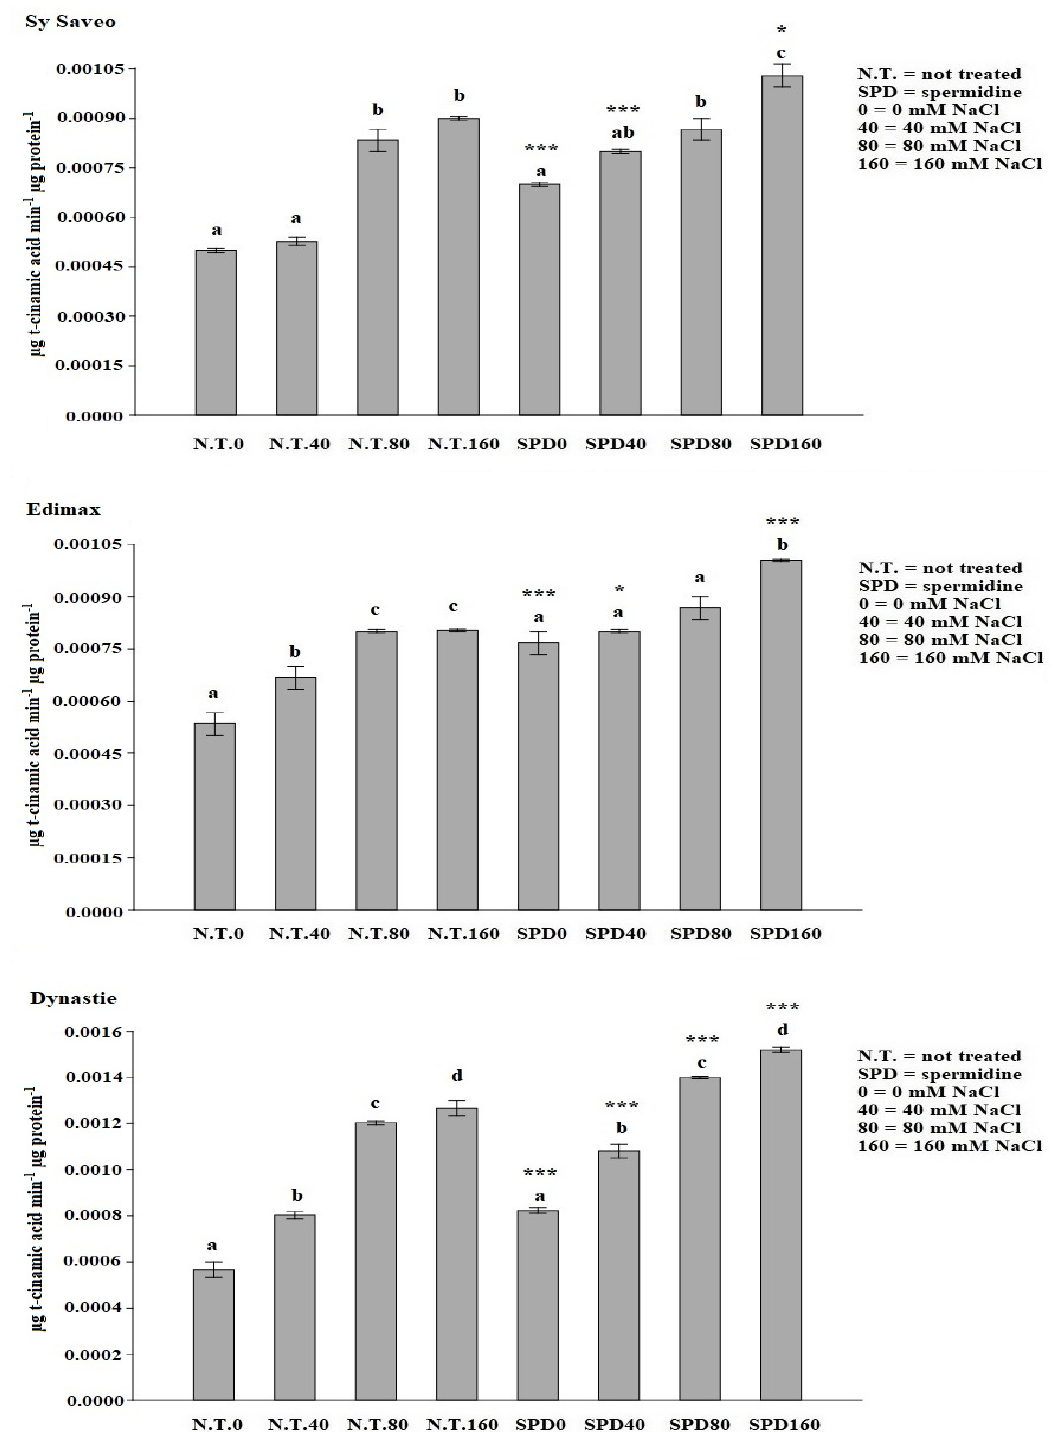
Figure 2. Effect of spermidine priming on PAL activity of rapeseed cultivars exposed to saline conditions. Data are expressed as means ± SE ( n = 3). Mean values in the column marked by different letters are significantly different within the same group ( p ≤ 0.05; ANOVA and Tukey–Kramer test). Significant differences between groups are reported as * p < 0.05; *** p < 0.001. The enzymatic antioxidant response was evaluated by determining SOD